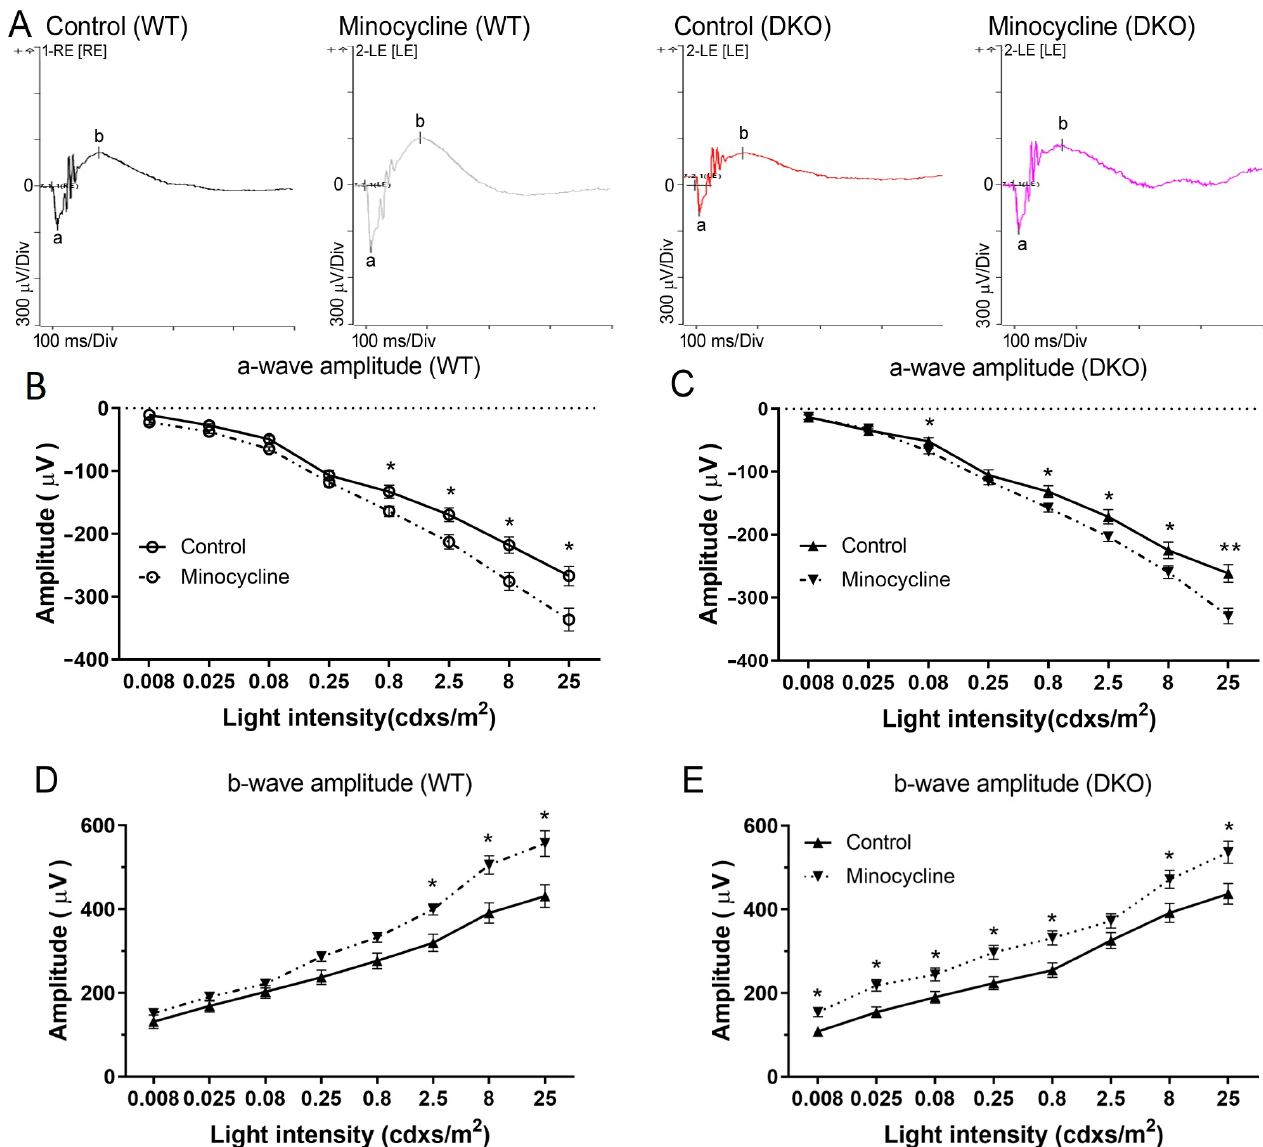
Figure 2. The effect of minocycline on visual function measured by electroretinography (ERG). ( A ) Representative images of scotopic ERG from vehicle-treated or minocycline-treated wild type (WT) and double knockout (DKO) mice. ( B , C ) a-wave amplitude of vehicle- and minocycline-treated WT ( B ) and DKO ( D ) mice. ( D , E ) b-wave amplitude of vehicle- and minocycline-treated WT (B) and DKO ( D ) mice. Mean ± SEM, n ≥ 8 mice (16 eyes), * p < 0.05, ** p < 0.01 compared to the same light intensity of vehicle-treated mice by 2- way ANOVA with Sidak’s multiple comparison test .